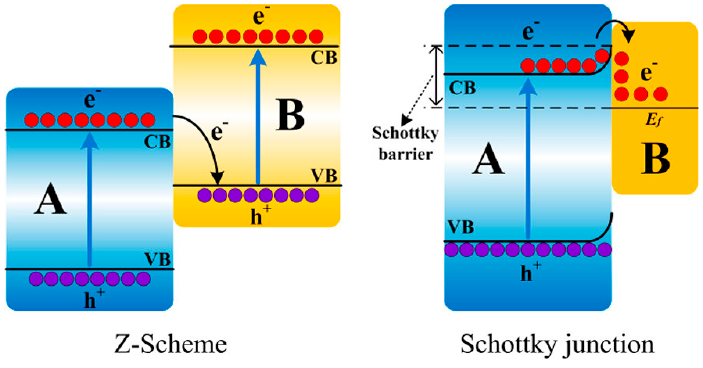
Figure 1. Schematic diagram of charge transfer for Z-scheme and Schottky junction systems. Adapted with permission from [7].